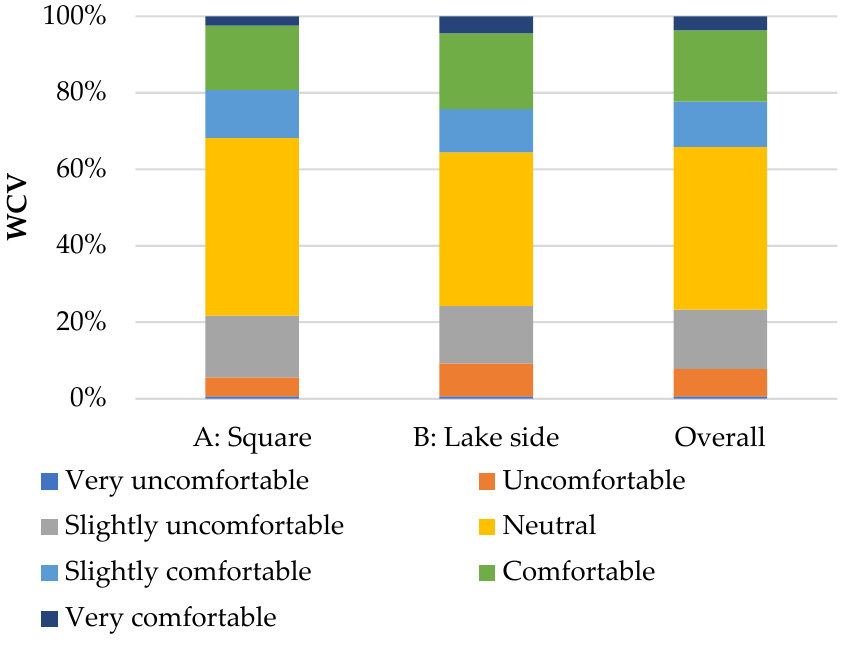
Figure 5. Distribution of WCV.